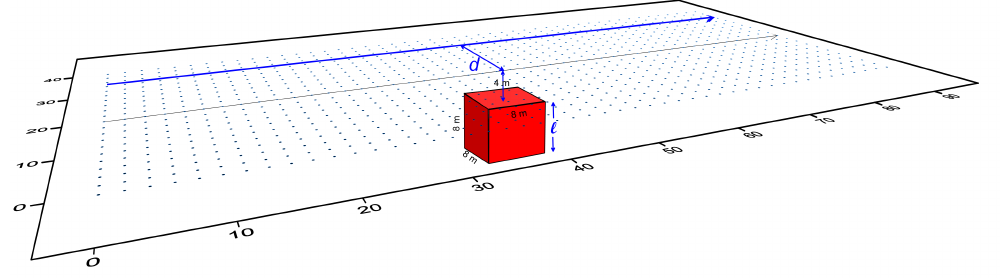
Figure 1. Simulation of a 3D ERT survey on a model of a cube-shaped resistive block (10 5 Ω · m) buried in a background rock (100 Ω · m). The blue points indicate the electrode positions. The size l of the cube is equal to 8 m. The depth of the top of the cube is 4 m. The thick blue line indicates the considered 2D-ERT survey, carried out at an orthogonal distance d from the projection on the surface of the cube’s